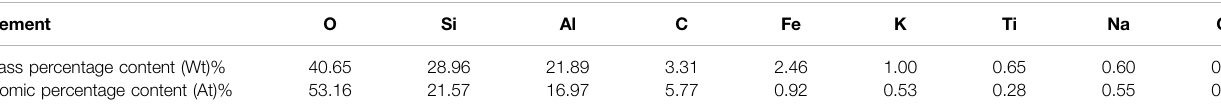
TABLE 1 | Composition and content of surface elements of fl y ash.